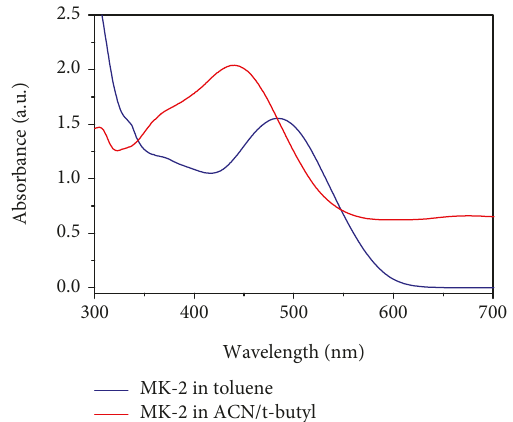
Figure 4: UV-visible absorption spectra of the MK-2 dye dissolved in acetonitrile/ tert -butyl (1 :1 v / v ratio) and in toluene are indicated by the red line and the blue line, respectively.